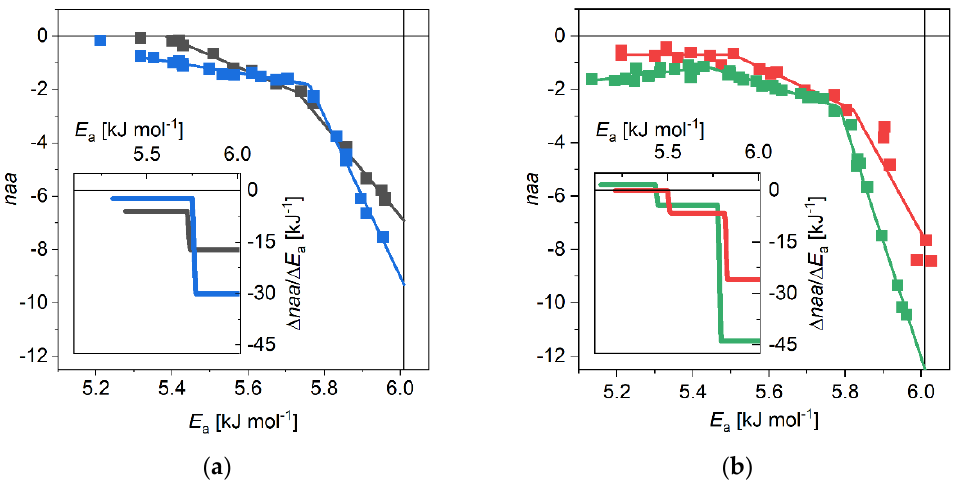
Figure 1. ( a ) Wild type α -synuclein, oligomer-monomer (grey) and amyloid–monomer (blue) melting diagrams; ( b ) A53T α -synuclein, oligomer–monomer (red) and amyloid–monomer (green) melting diagrams. Mol H 2 O per mol amino acid residue ( naa ) vs. potential barrier. Lines are guides to the eye. The insets are the derivative forms of the difference melting diagrams. Mol H 2 O per mol amino acid residue ( naa ) vs. potential barrier. Lines are guides to the eye. The insets are the derivative forms of the difference melting diagrams.